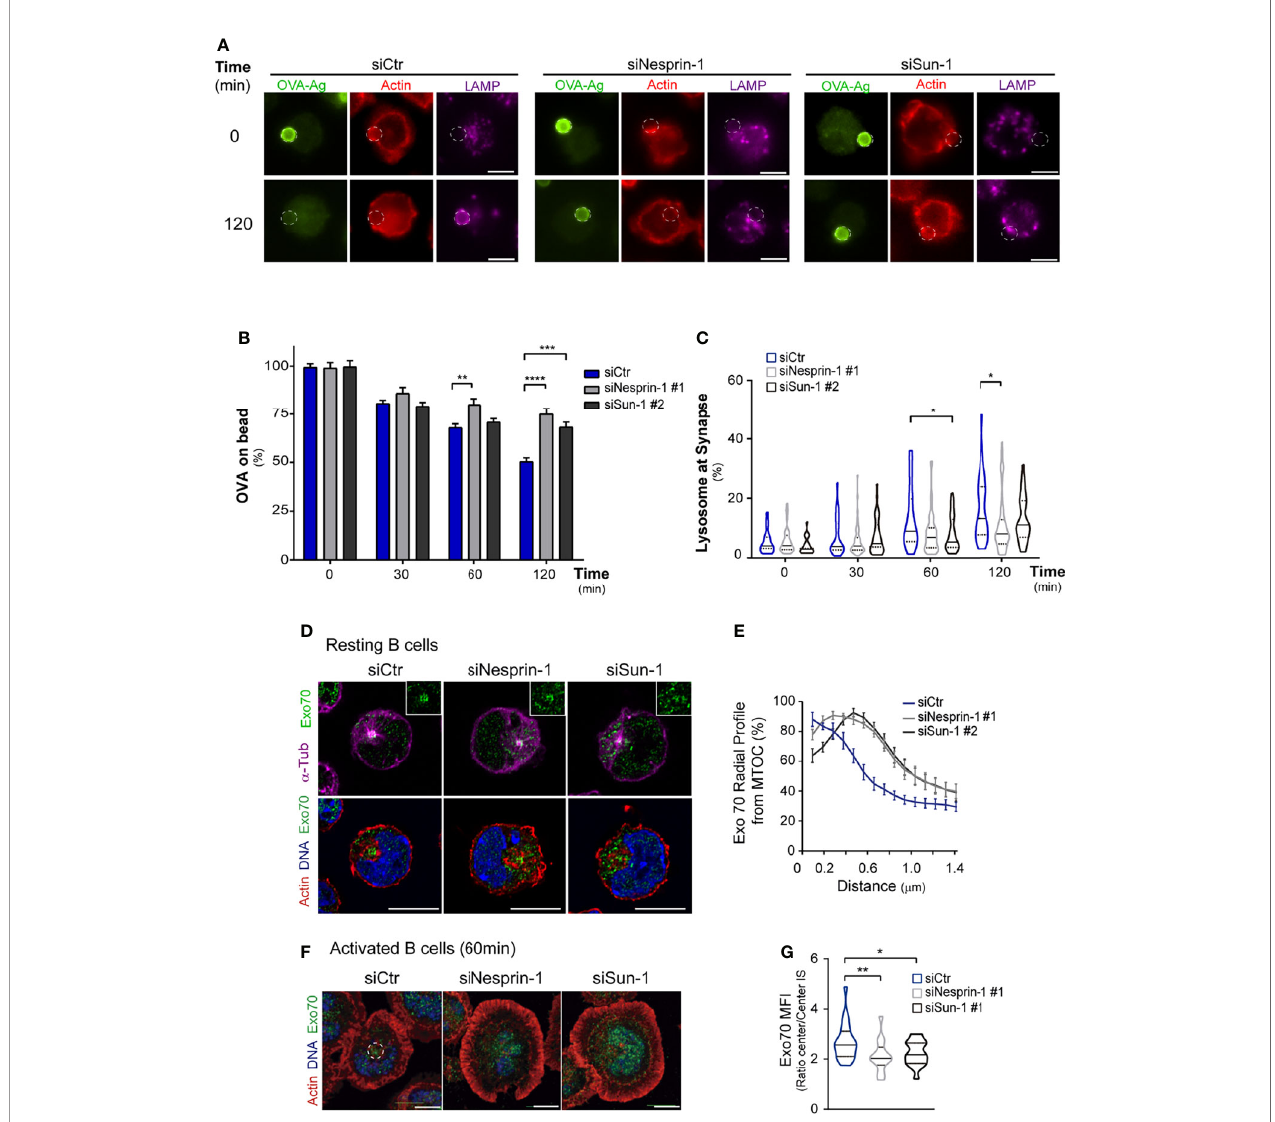
FIGURE 5 | Antigen extraction relies on Nesprin-1 and Sun-1. (A) Epi fl uorescence images of control or Nesprin-1- and Sun-1-silenced B cells incubated with antigen-coated beads for 0 or 120 min. Cells were stained against OVA (Green), actin (red), and LAMP1 (magenta). White circles indicate bead position. Scale bar 5 m m. (B) Percentage of OVA remaining on antigen-coated beads; n=80, **p = 0.001; ***p = 0.0006; ****p < 0.0001. Means with SEM lines shown. (C) Measurement of LAMP1+ rings surrounding antigen-coated beads; n=80; *p=0.05. (D, E) Confocal images of silenced B cells (as in A) under resting conditions, showing Exo70 (green) with: upper panel, microtubules/MTOC ( a -Tub, magenta); and lower panel, actin (red) and nucleus (Hoechst, blue). Quanti fi cation of Exo70 distribution (radial pro fi le) from the MTOC. n>30. (F, G) Confocal images of silenced B cells (as in A ) activated on antigen-coated dishes for 30 min. Exo70 (green), actin (red) and nucleus (Hoechst, blue). Quanti fi cation of Exo70 concentration in central region of immune synapse; n=40, *p < 0.05, **p < 0.01. Statistical analyses: Kruskal-Wallis with Dunn ’ s multiple comparisons tests (B, C, G) , mixed-effects analyses, and Dunnett ’ s multiple comparisons tests (E)